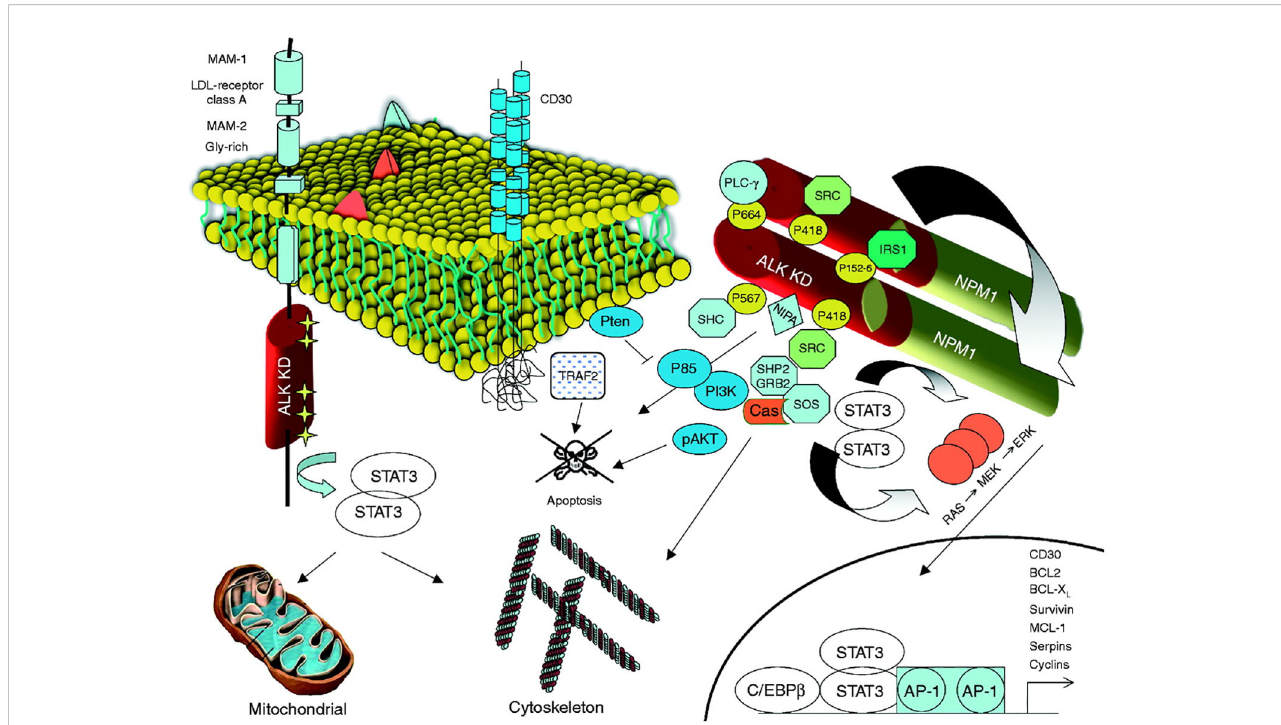
FIGURE 2 ALK and its signaling transduction pathways. Mutated ALK-R and ALK fusion proteins can elicit multiple signaling pathways, which are responsible for cell transformation and for the maintenance of the neoplastic phenotype. The kinase activation, in both mutated ALK and ALK chimeras, is associated with the docking of several adaptors, which in turn fi re several signaling pathways. A critical oncogenic player is represented by the JAK/STAT3 pathway, which provides essential survival signals and modulates the cellular metabolism regulating the mitochondrial oxidation chain. STAT3 is activated by ALK either directly or through JAKs. Reproduced from Journal of Molecular Endocrinology 47, 1;